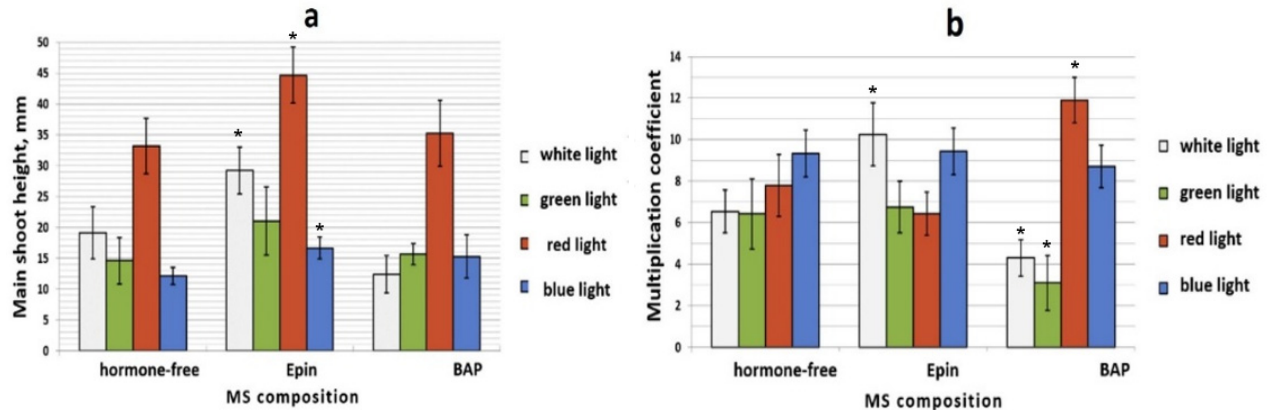
Figure 7. The influence of different LED lighting and PGRs combinations on ( a ) main shoot height and ( b ) the multiplication coefficient of S. rebaudiana microshoots in vitro. Means ± standard errors at α = 0.05 according to ANOVA tests ( n = 60). *-variants of culture media that have significant differences between controls (MS media without PGRs).